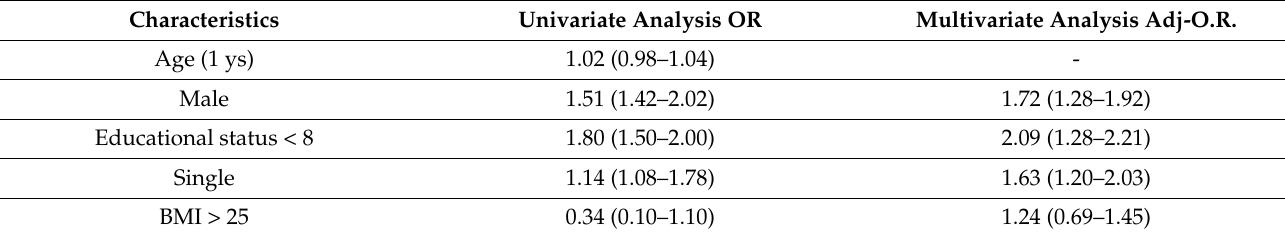
Table 5. Factors associated with a low knowledge of